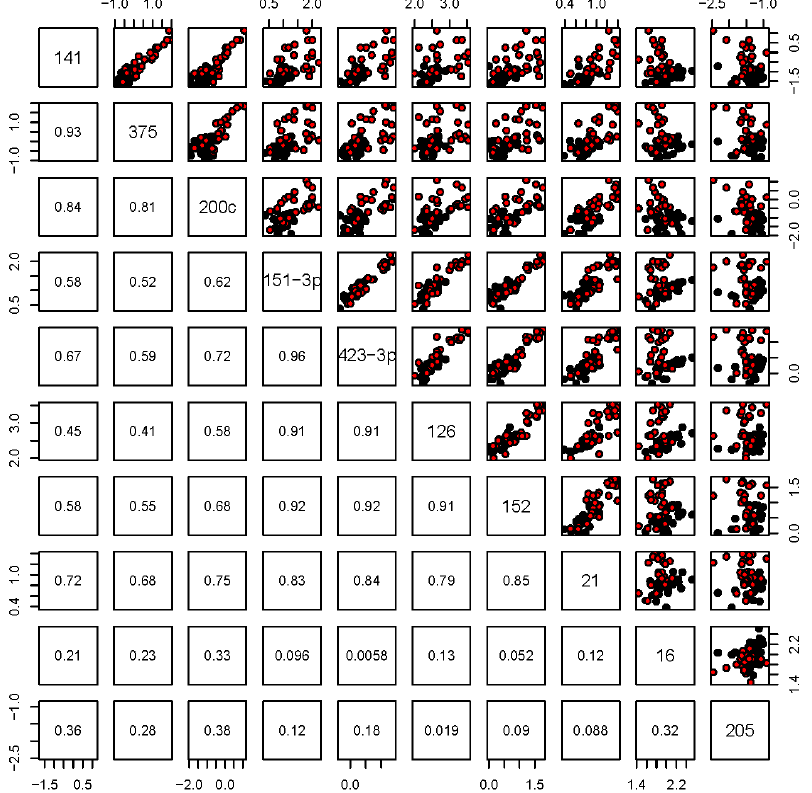
Figure 2. Pearson’s correlation amongst the validated differentially expressed miRNAs. Black dots represent localized PCa, and red dots represent mCRPC.